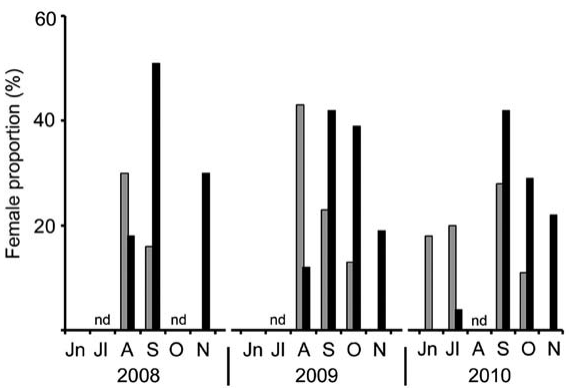
Fig. 8. – Sexual maturity in field samples of young of the year (females) of Munida gregaria in San Jorge Gulf. Grey bars show proportion of females that reached gonadal maturity. Black bars represent proportion of ovigerous